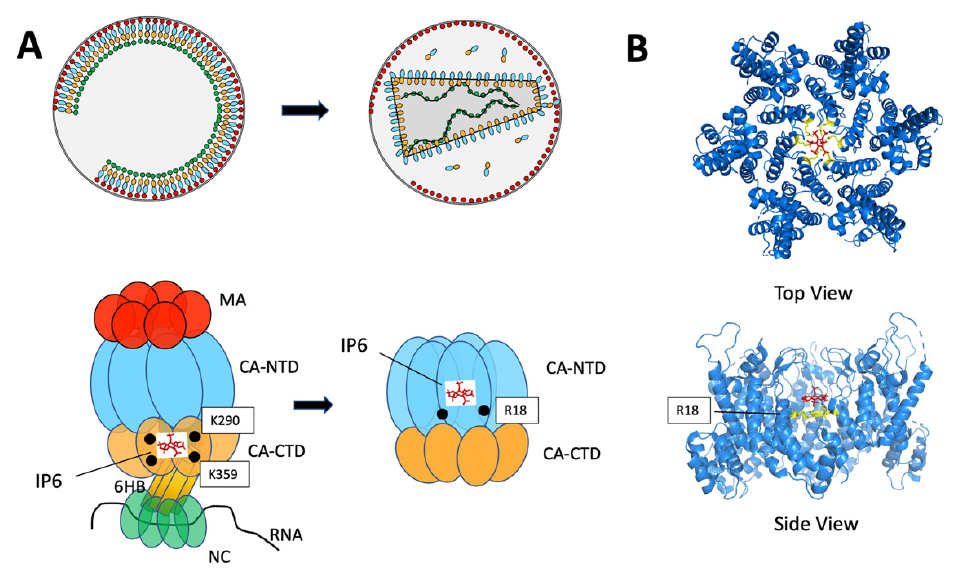
Figure 4. Role of IP6 in immature Gag lattice and in mature capsid core formation. ( A ) Schematic depiction of maturation of immature lattice to mature core formation, with structural model below showing position of IP6. Note that IP6 is coordinated by K359 and K290 rings in immature hexamer (left), while it interacts with R18 in the mature viral core. Figure adapted from findings of [189]. ( B ) Top and side views of IP6 in mature lattice, with positions of R18 residues indicated in yellow. IP6 is depicted in red. From PDB 6BHT [189]. Structures rendered by the PyMOL Molecular Graphics System, Shrodinger, LLC.